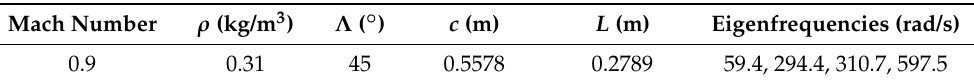
Table 3. Parameter values and structural eigenfrequencies for the AGARD 445.6 weakened model. The reference length is the half chord length at the wing root, L = c